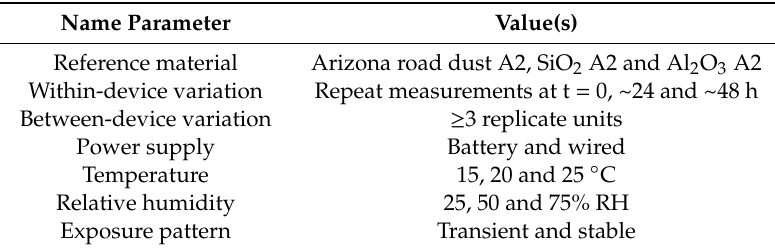
Table 2. Evaluation